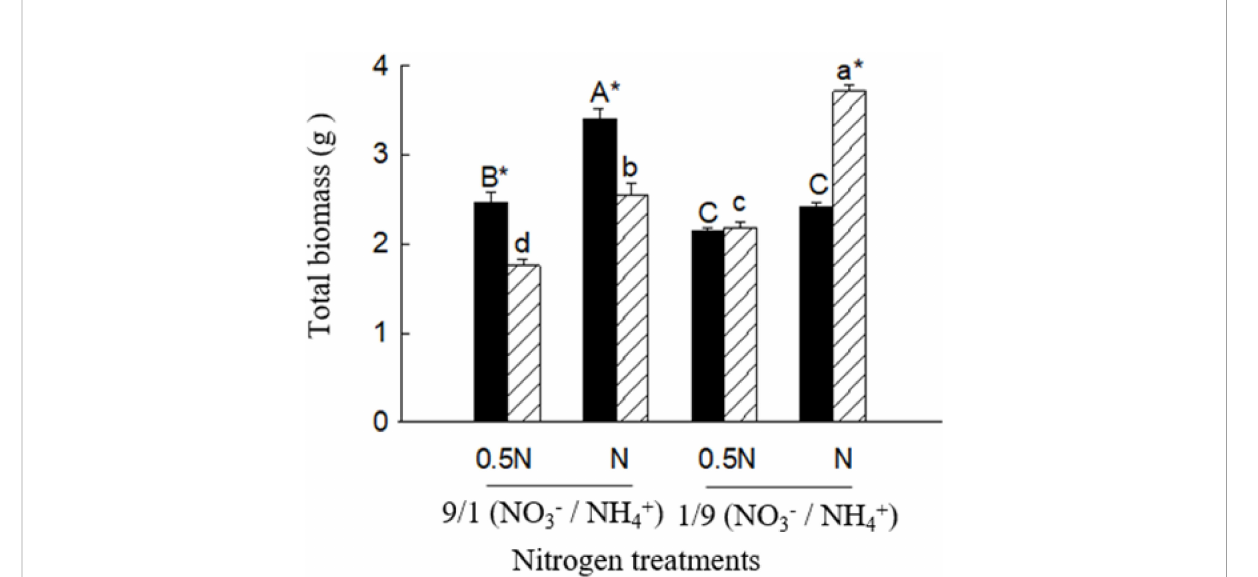
FIGURE 7 Total biomass of Xanthium sibiricum (striped bars) and X. strumarium (closed bars) in different nitrogen treatments. 0.5 N and 1 N indicate 50% and 100% nitrogen concentration of the Hoagland nutrient solution, respectively. Means + SE ( n = 6). Different upper- and lowercase letters indicate signi fi cant dfferences among nitrogen treatments for X. strumarium and X. sibiricum , respectively ( P < 0.05; one-way ANOVAs); * indicates signi fi cant difference between the invasive and native species in the same treatment ( P < 0.05; independent sample t -test).